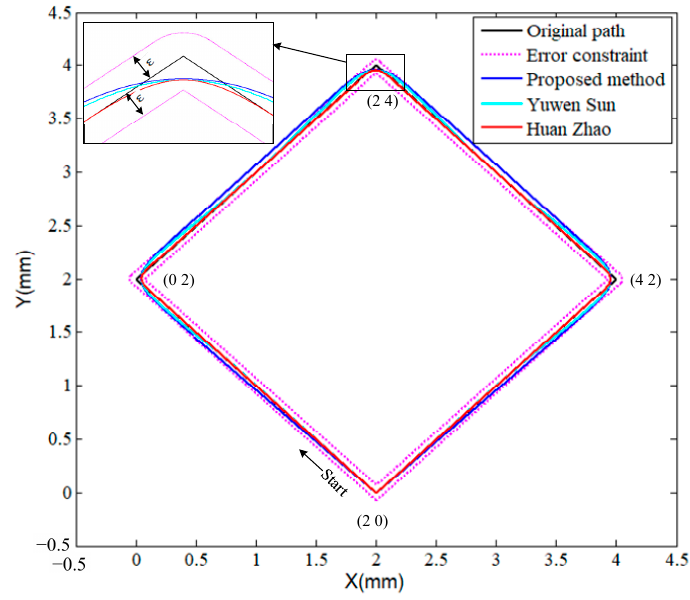
Figure 3. Corner-smoothing using three methods in rhombic tool